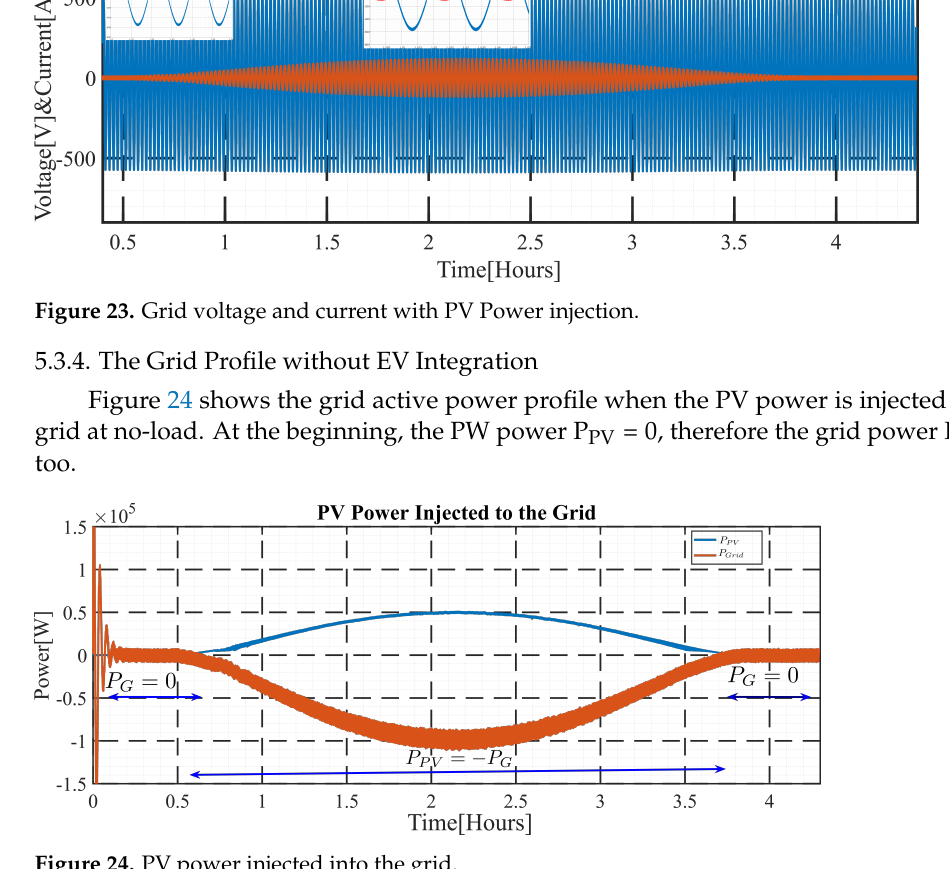
Figure 24. PV power injected into the